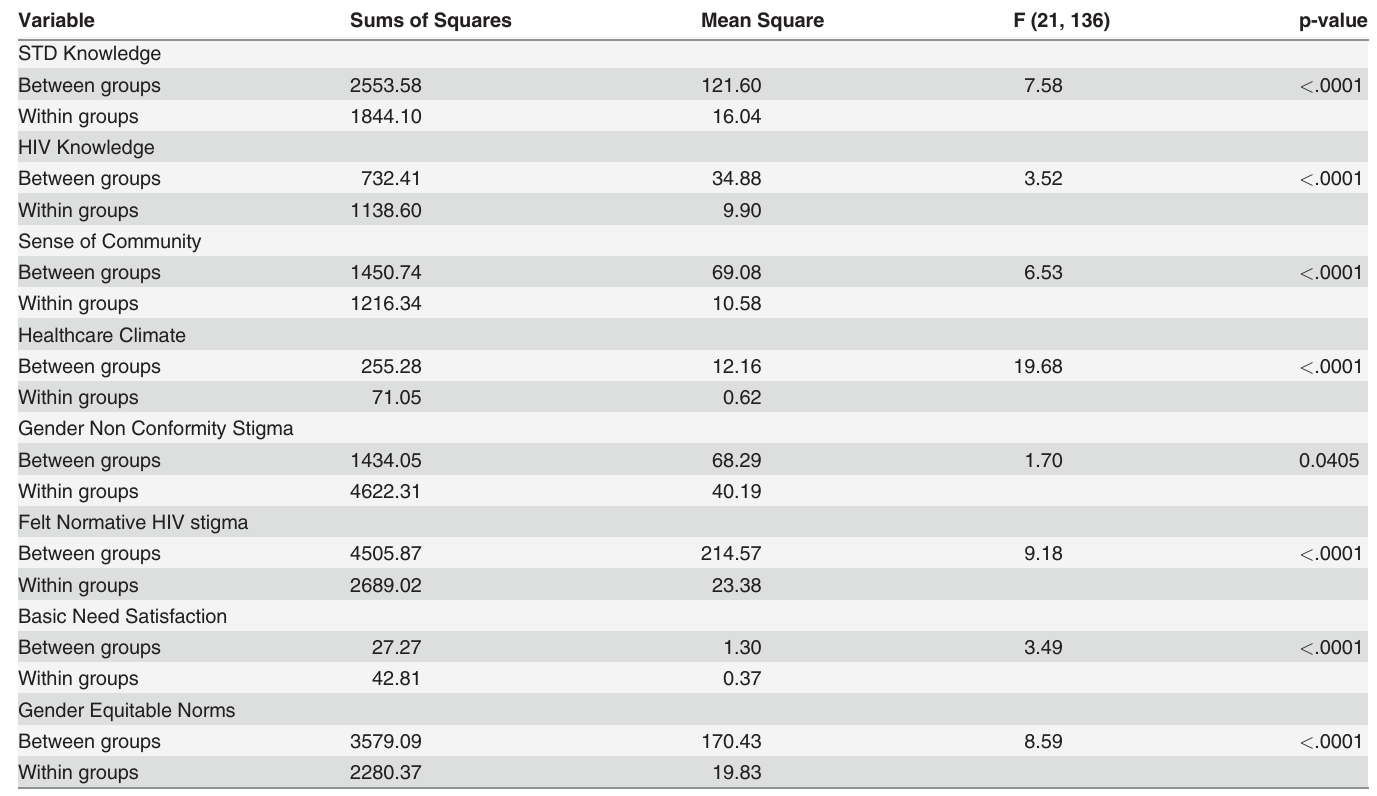
Table 4. Results of ANOVA Comparing Peer Network Mean Scores on Psychosocial